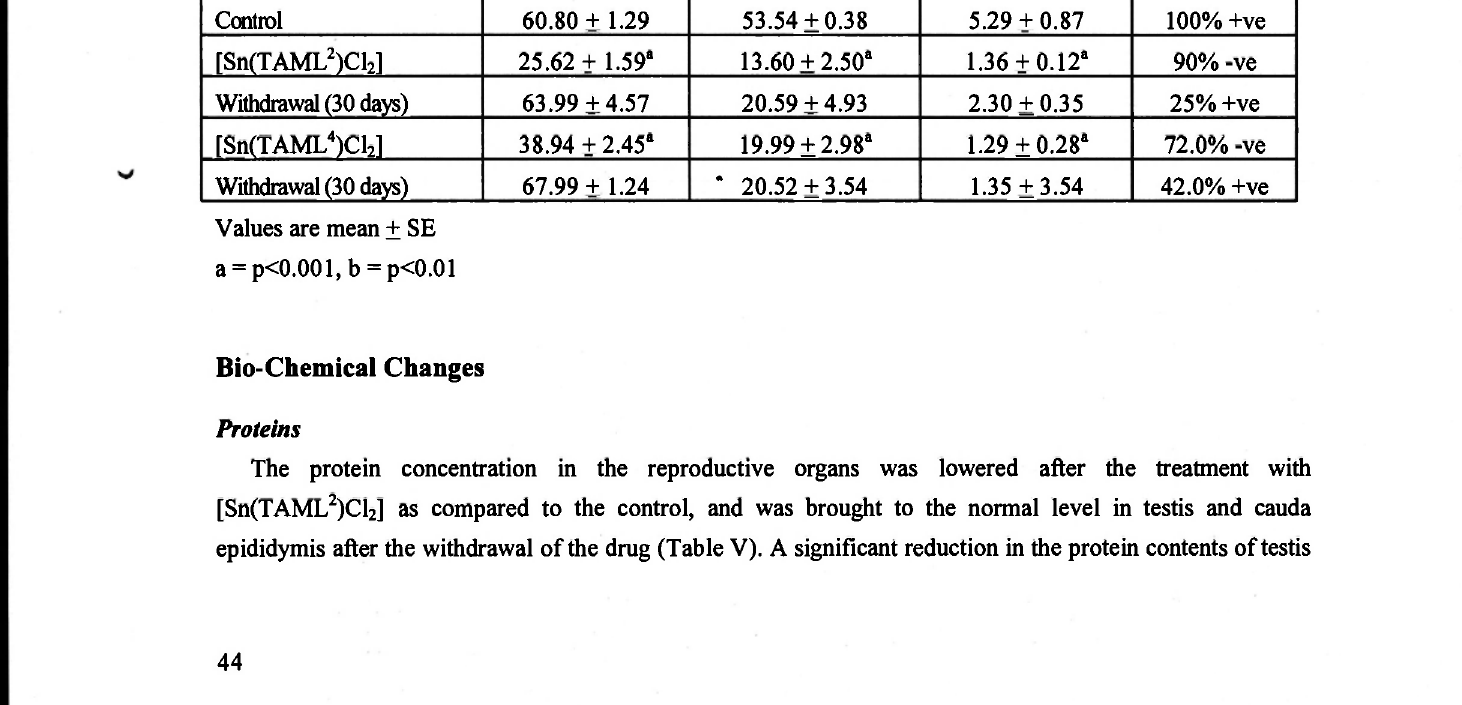
Sperm motility, sperm density and fertility rate of control, Sn(TAML 2 )Cl 2 ] and [Sn(TAML 4 )Cl 2 ] treated and withdrawal group of